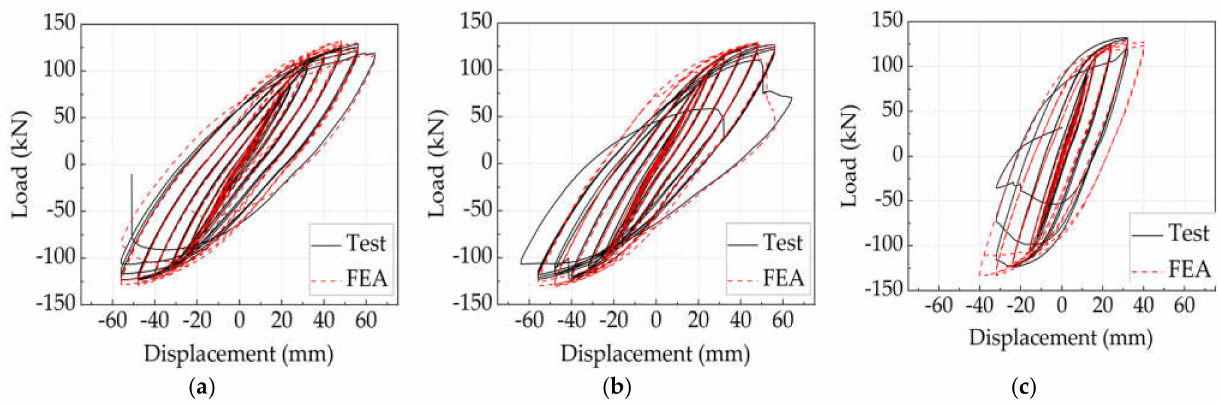
Figure 19. Comparison of hysteresis curves between test and FEA results: ( a ) Specimen S–CFT–A;